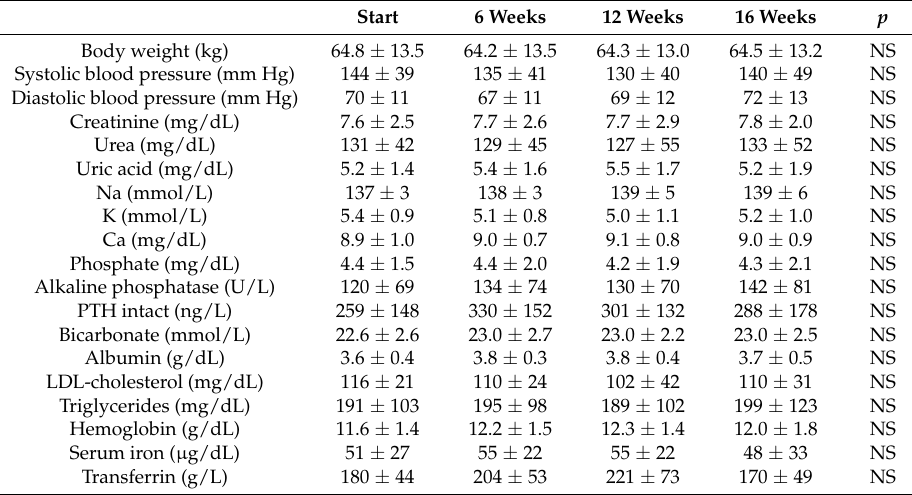
Table 2. Physical and biochemical parameters at the study baseline, after 6 and 12 weeks of intervention and 4 weeks after withdrawal of the sodium propionate (SP)